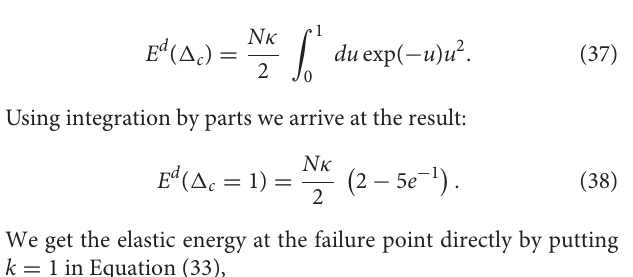
10 7 fibers. Circle =